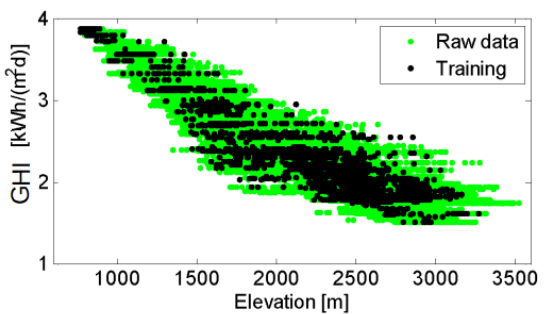
Figure 6. Cross-correlation plot of available (raw) data and the extracted training data for radiation and